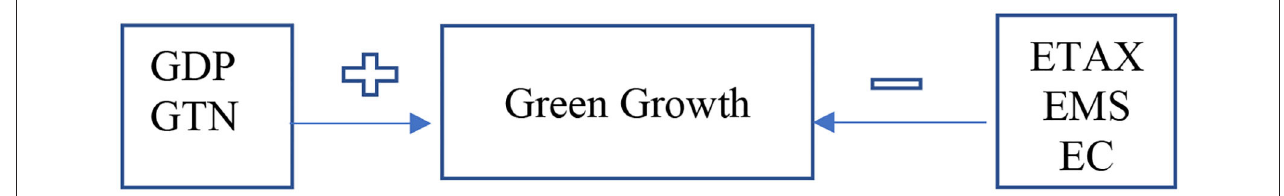
FIGURE 1 | Theoretical